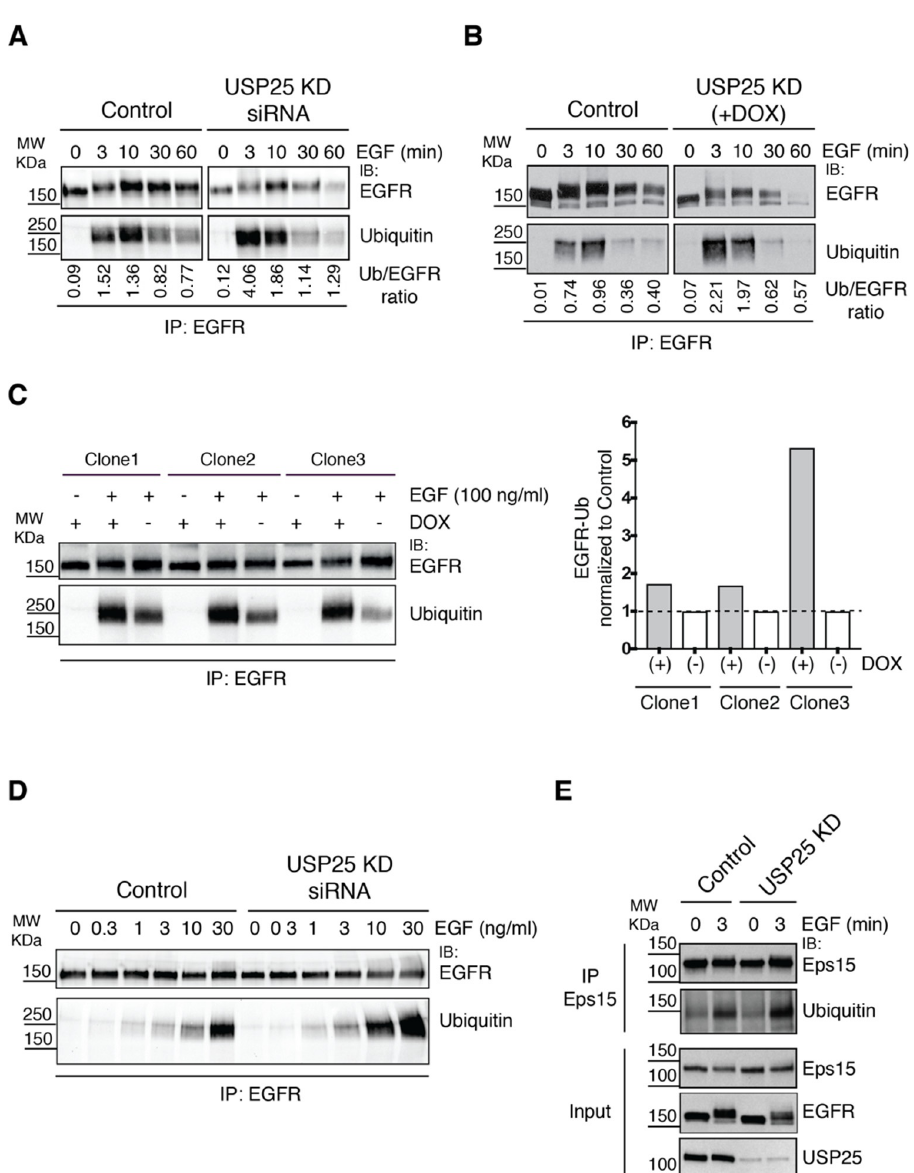
Figure 4. EGFR ubiquitylation dynamics is affected by USP25 depletion. ( A ) Immunoprecipitation (IP) and IB analyses of HeLa cells transfected with a RNAi oligo targeting USP25 or a scramble oligo (control). Serum-starved cells were stimulated with EGF (100 ng/mL) as indicated. 500 μ g of cell lysates were IP and analyzed by IB as indicated. ( B ) IP and IB analyses, as in A, of a stable HeLa cell line carrying a shRNA targeting USP25 and control cells. USP25 depletion was induced with doxycycline treatment (0.5 μ g/mL). ( C ) IP and IB analyses, as in B, of EGFR ubiquitylation after 3 min of EGF stimulation (100 ng/mL) in three different HeLa-USP25 shRNA inducible clones. USP25 depletion was induced with doxycycline treatment (0.5 μ g/mL). Right panel: quantification of Ubiquitylated EGFR normalized to control. The dotted line indicates the value of the control. ( D ) IP and IB analyses, as in B, using different EGF concentrations, as indicated. ( E ) IP and IB analyses, of cells as in B, using an anti-Eps15 antibody. Input (50 μ g) corresponds to 10% of total immunoprecipitated proteins.